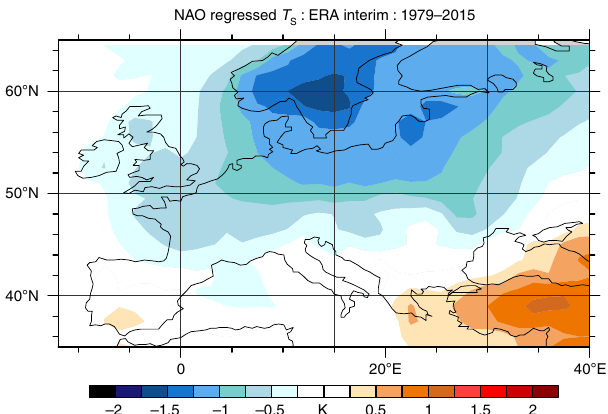
Fig. 2 Regional temperature structure of the NAO. Regression of the negative phase of the NAO during June through August against contemporaneous surface temperature for the region considered in Fig. 1 (see “ Methods ” ). Contributions to cooling from the negative phase of the NAO are greatest in regions where the model forced response fails to reproduce the cooling estimated in